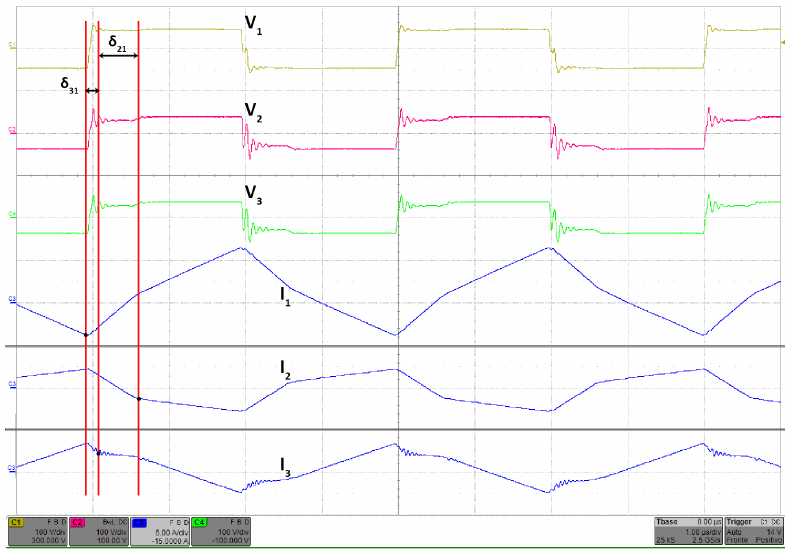
Figure 18. Experimental results of the transformer voltages V 1 (yellow), V 2 (red), V 3 (green) and currents I 1 , I 2 and I 3 (blue), with V PV = 50 V, V BAT = 12 V, R LOAD = 20 Ω , δ 12 = 0.15 and δ 13 = 0.05. Settings of the oscilloscope are: 100 V/div for the voltages; 5 A/div for the currents; time base of 1 µ